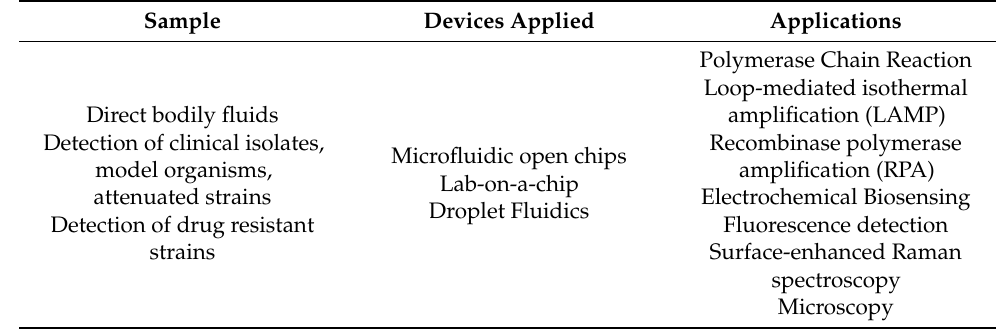
Table 1. Summary of current microfluidic applications for diagnostics and detection of M. tuberculosis